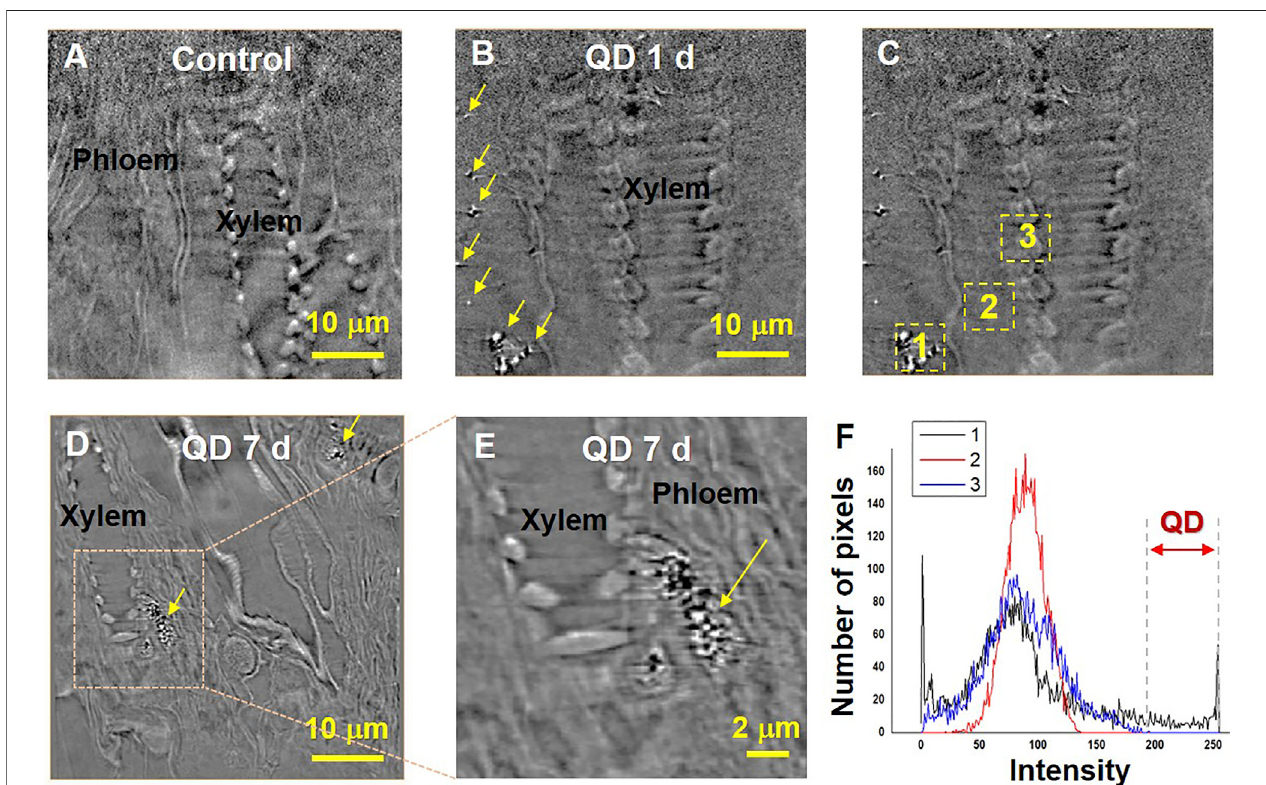
FIGURE 4 | Translocation of QD NPs within garlic chive plants after their foliar uptake. X-ray images of the control (A) and QD-exposed leaves (B – E) captured by nano-CT. 2D slices extracted from the reconstructed 3D images. Yellow arrowheads indicate QD NPs. QD 1 d and 7 days represent X-ray images captured at 1 and 7 days after foliar exposure to 1 mg/ml QD suspension (2 μ L drop deposition), respectively. To determine the existence of QD, area histograms (F) of the three different regions (C) were compared. The two way red arrow (the region of intensity 200 – 250) indicates a range of brightness regions only for QD